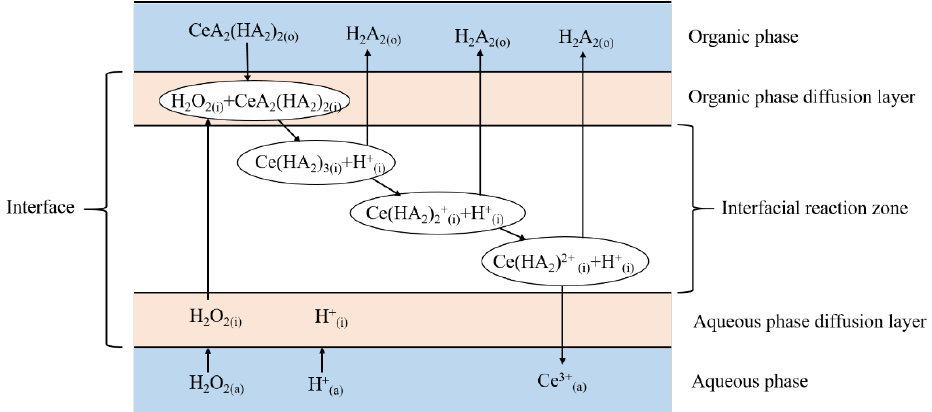
Figure 9. Schematic diagram of mass-transfer process of cerium stripping.